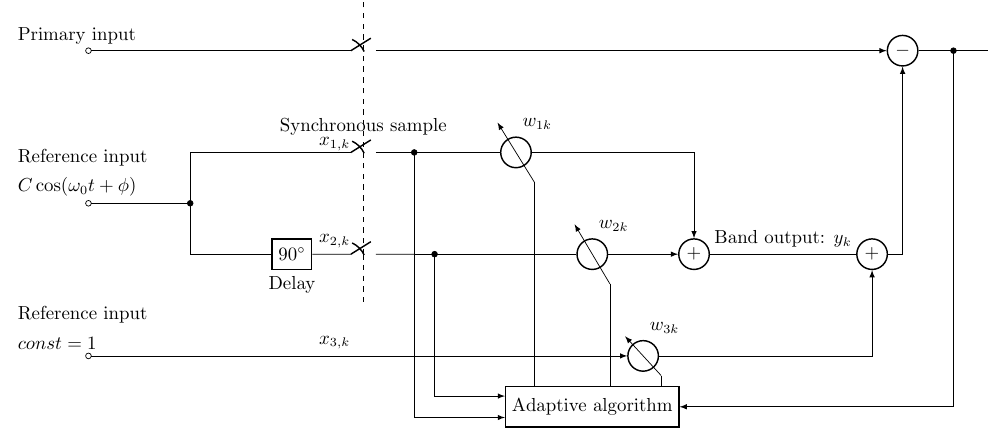
Figure 11. Structure of the modified adaptive